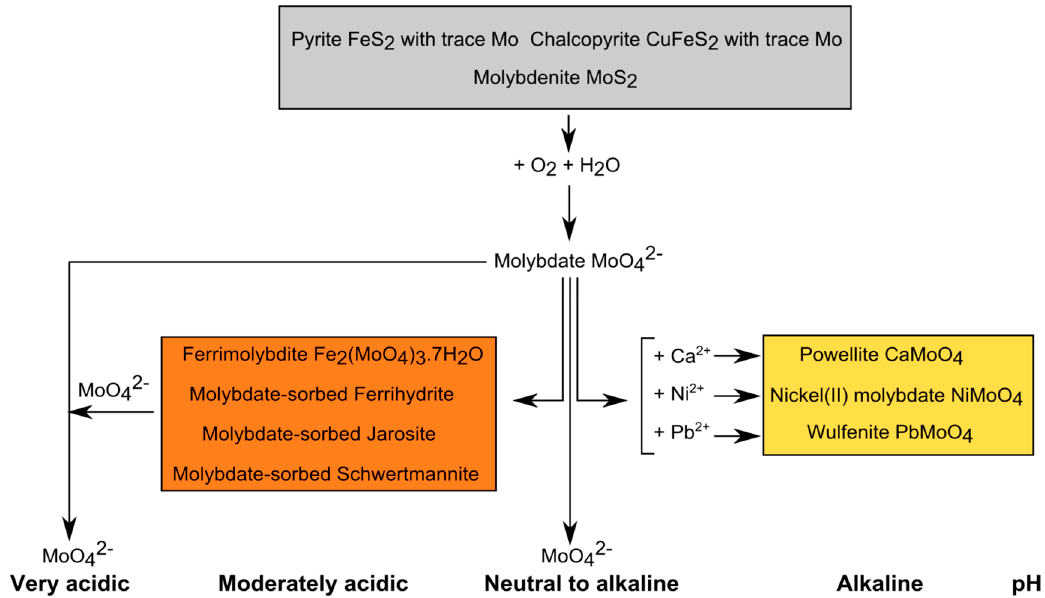
Figure 3. Schematic diagram illustrating the relationships between, and formation of, Mo-bearing minerals in mine wastes. Solid minerals are shown in boxes, and relationships between them involving aqueous species are shown with arrows. The pH conditions under which the minerals and aqueous species are stable are indicated at the bottom of the figure.